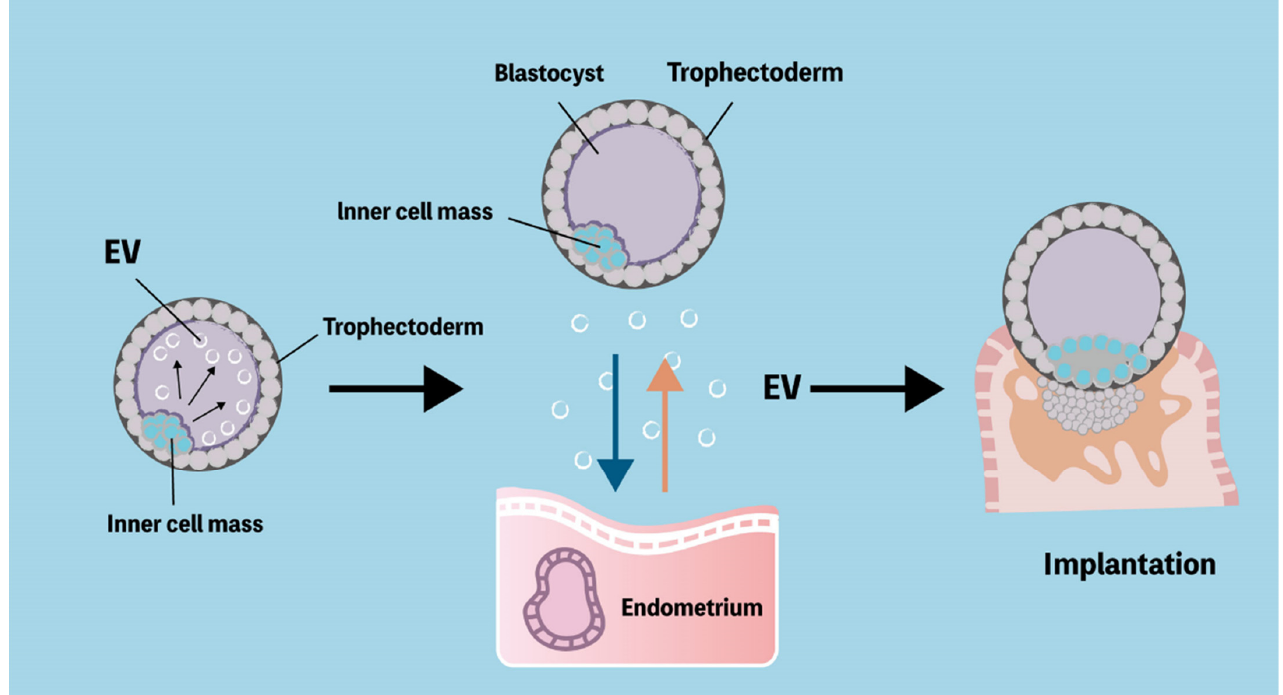
Figure 3. Extracellular vesicles provide intercellular communication both between embryos and endometrium. Extracellular vesicles (EVs) extend across the blastocoel and link the mural trophecto- derm and inner cell mass. Trophectoderm cell line releases miRNA-containing EVs that stimulate endometrial epithelium. The communication between blastocyst and endometrium triggers success ‐ ful embryo implantation.